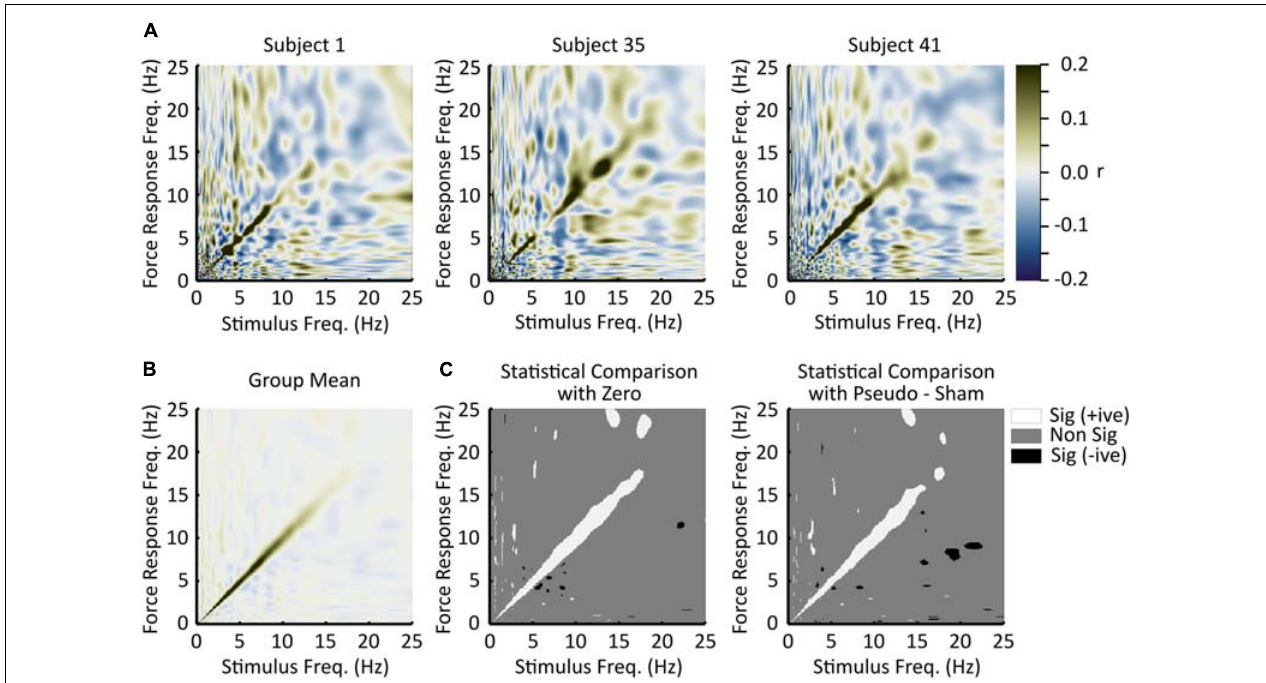
FIGURE 2 | Experimental results. (A) Single subject responses ( n = 1). These plots are the correlation matrices for three subjects. On the horizontal axes are stimulus frequencies and on the vertical axes are response frequencies. Correlation strength is represented by the color scale. Dark green indicates strong positive correlations, white indicates low correlations, and dark blue indicates strong negative correlations. In general, the strongest (positive) correlations were observed along the diagonal, indicating a linear frequency relationship between the stimulus and the induced responses. (B) Grand mean correlation matrix across all subjects. While there is high variance within each subject, on average ( n = 45) responses induced by the stimulus were at the same frequency as the stimulus. Panel (B) uses the same scale bar as panel (A) . (C) Statistical evaluation. The left plot illustrates responses significantly different from zero as defined by zero being outside of the bootstrapped 99% confidence interval for the mean ( n = 45). The right plot illustrates responses significantly different from zero defined as zero being outside of the bootstrapped 99% confidence interval of the difference of means distribution between the responses and the pseudo-sham ( n = 45). Both statistical tests reach similar outcomes, which was that responses to the stimulus predominantly occur at the same frequency as the stimulus. In these plots, white indicates significantly greater than zero (positive correlation), gray indicates non-significance, and black indicates significantly less than zero (negative correlation).